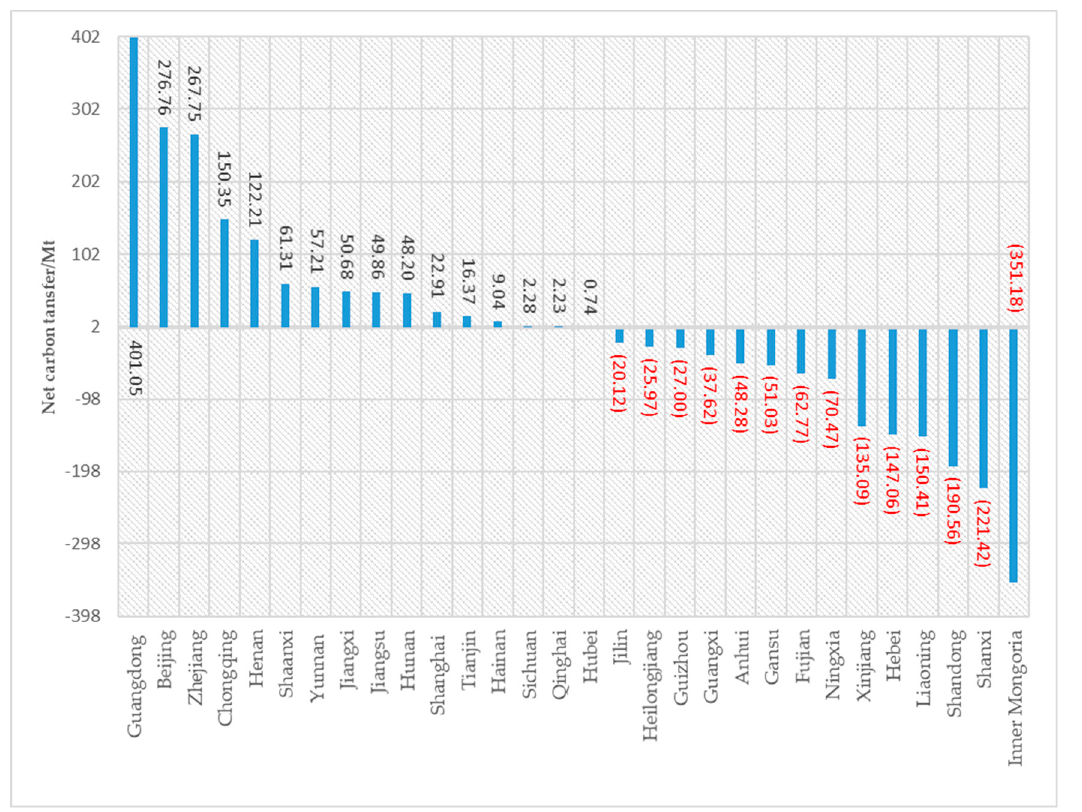
Figure 4. Net carbon transfer of provinces (cities and autonomous regions) in 2017.